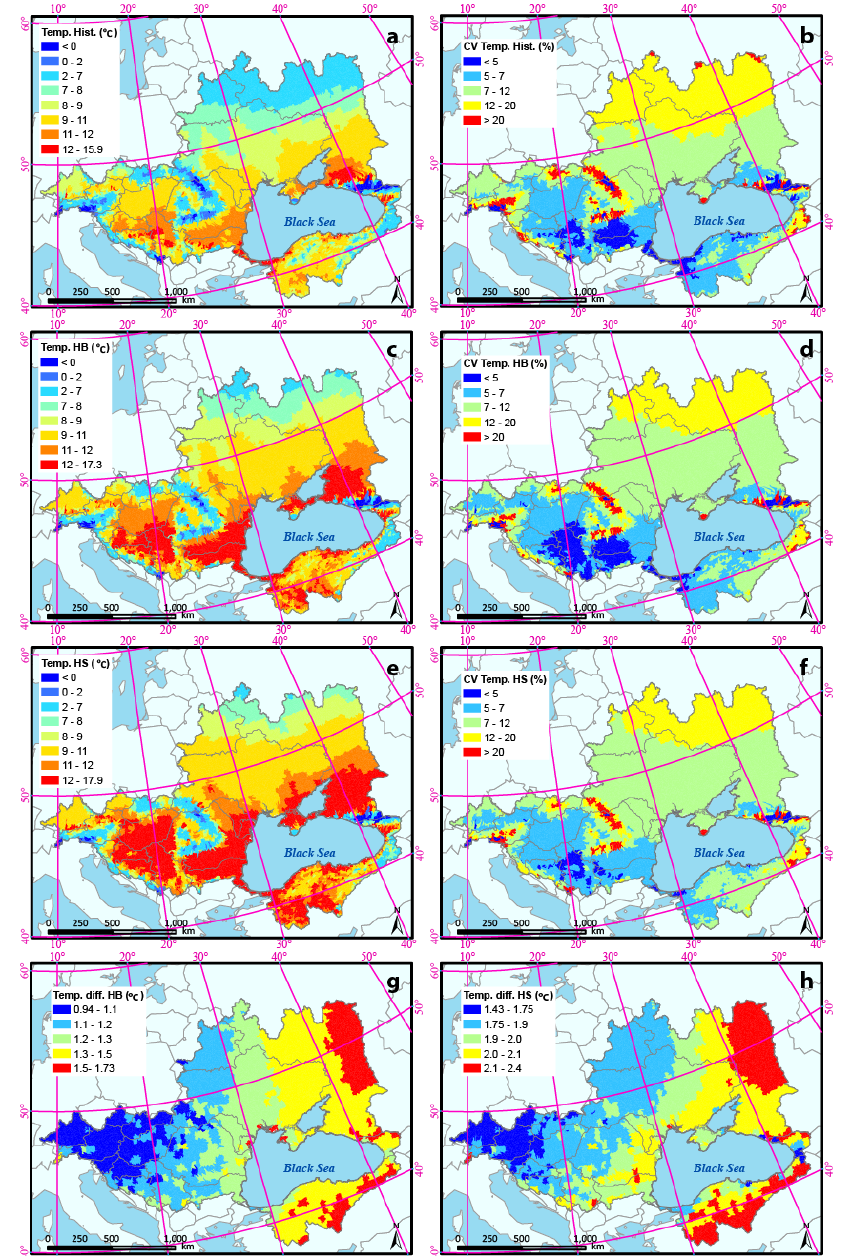
Figure 5. Temperature distribution in the Black Sea Catchment: ( a ) average temperature, historic (1973–2006); ( b ) coefficient of variation (CV) of historic temperature (1973–2006); ( c ) average